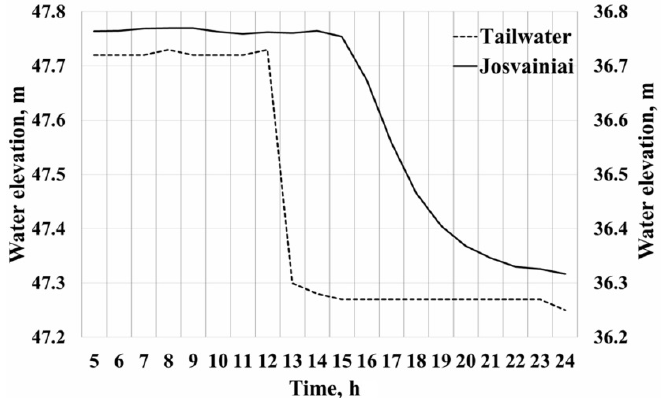
Figure 10. Stage dynamic at the tailwater of Angiriai SHP after shutting down 1 turbine ( Q T = 5 m 3 /s, HR 1 = 1.22) and 10 km downstream river at the Josvainiai gauging station. 10 May 2013. HR 1 =